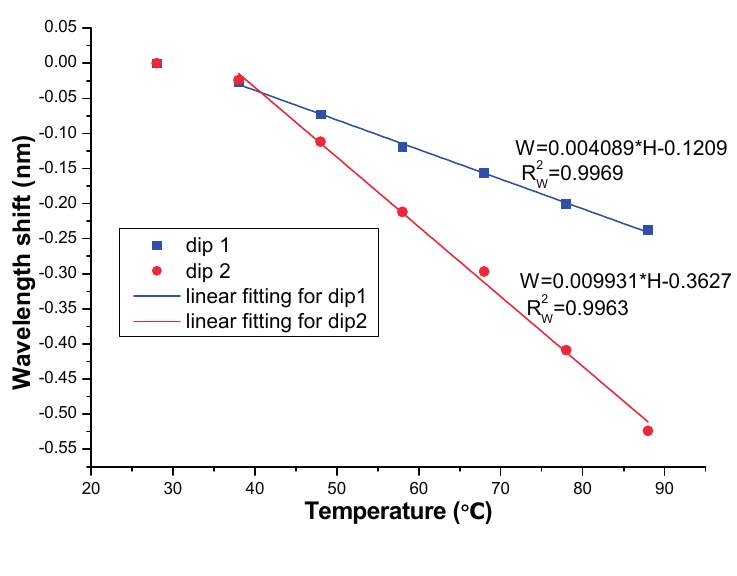
Figure 8. Wavelength of dips 1 and 2 change with